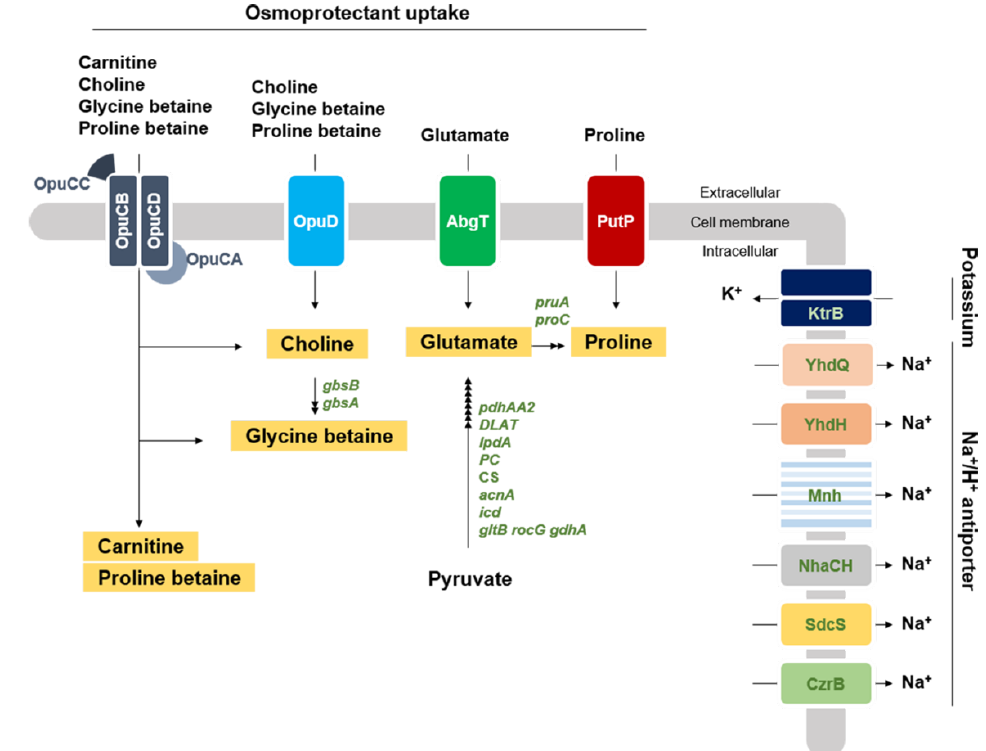
Figure 4. Predicted osmoprotectant transport and synthesis pathways in strain KM1031. Gene and osmoprotectant names are depicted in green italics and orange boxes, respectively. Transporter proteins are indicated in the cell membrane and their names are marked. The black arrows correspond to the potential enzymatic reactions catalyzed by gene products encoded in the genome of strain KM1031.